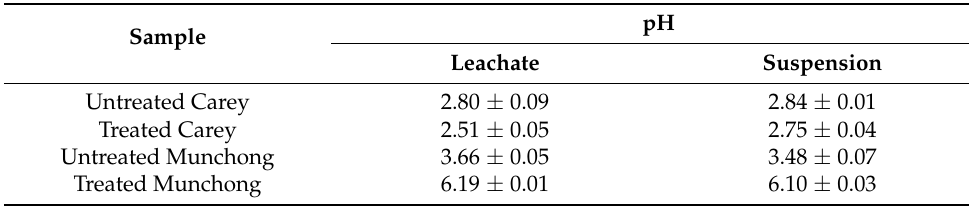
pH Leachate Suspension